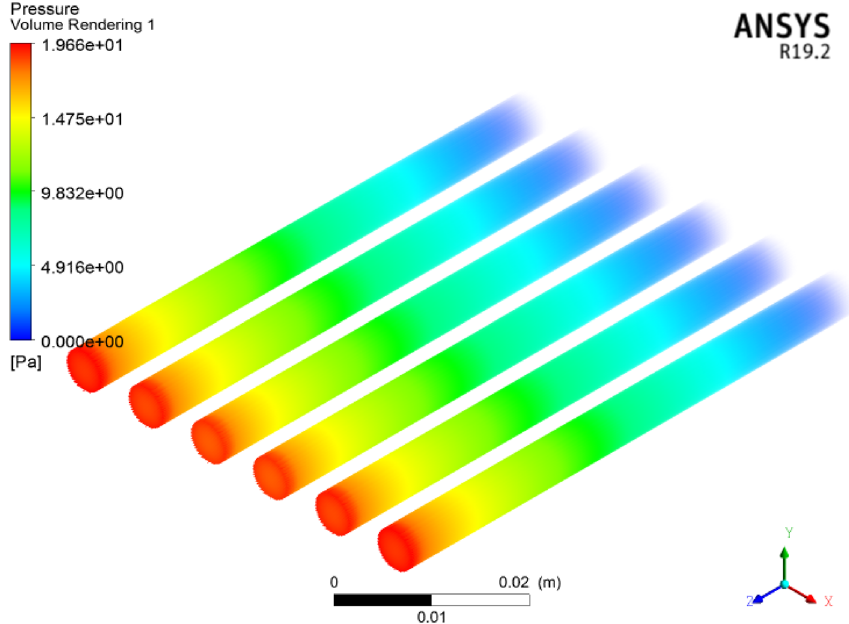
Figure 21. Cross-sectional observation of pressure in six circular microchannels.